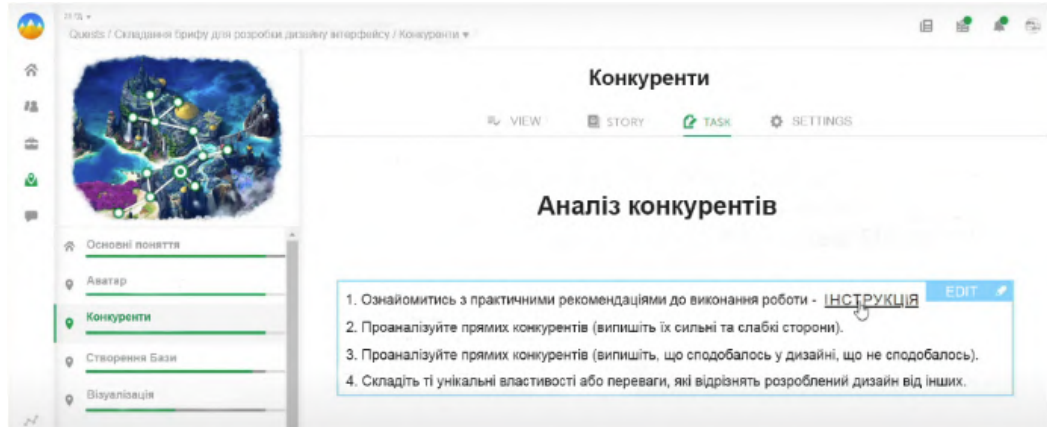
Figure 1: The episode of work upon the tasks of the quest station “Competitors” in the team quest “Brief creation for UI design”.